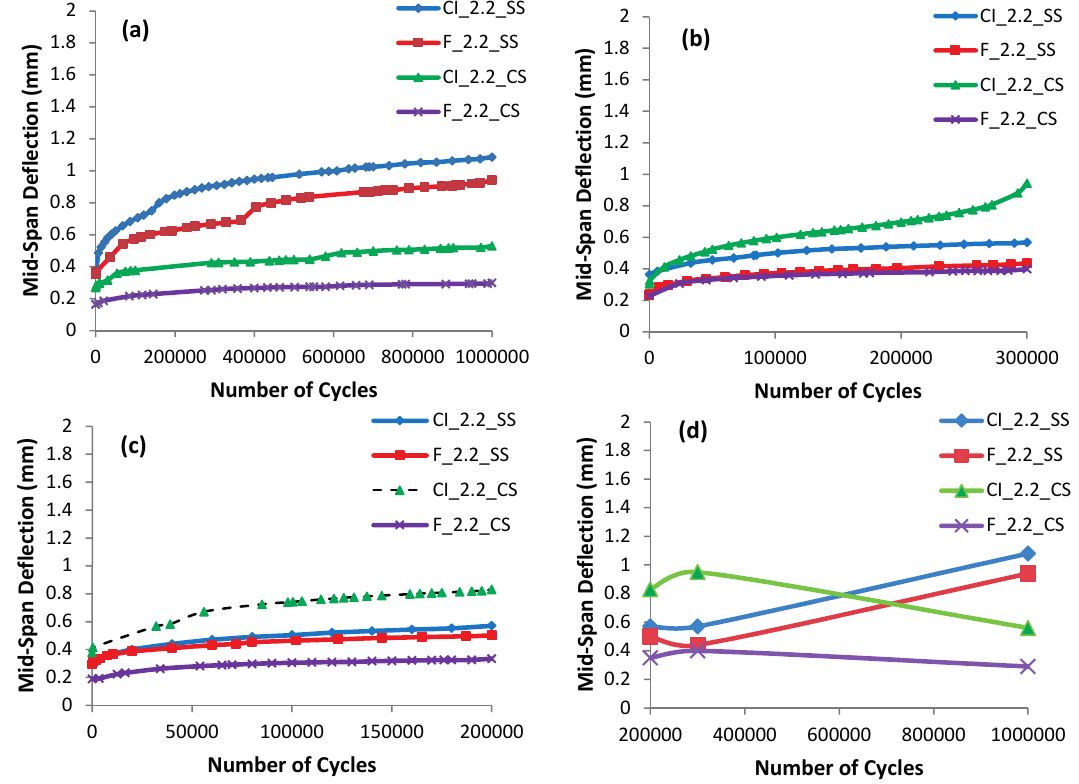
Figure 10. Evolution of mid-span deflection at 55% fatigue stress level and different number of cycles: ( a ) 1,000,000 cycles; ( b ) 300,000 cycles; ( c ) 200,000 cycles; ( d ) Trends showing deflection